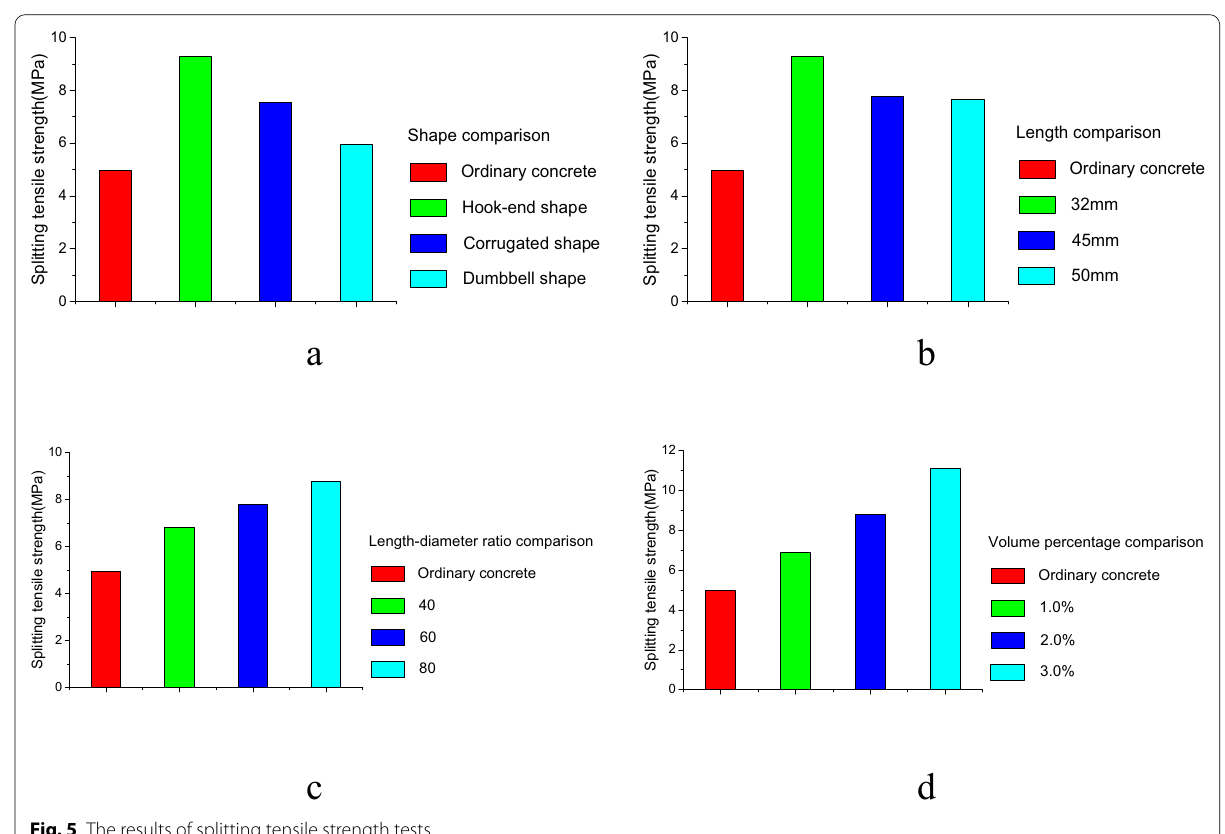
Fig. 5 The results of splitting tensile strength